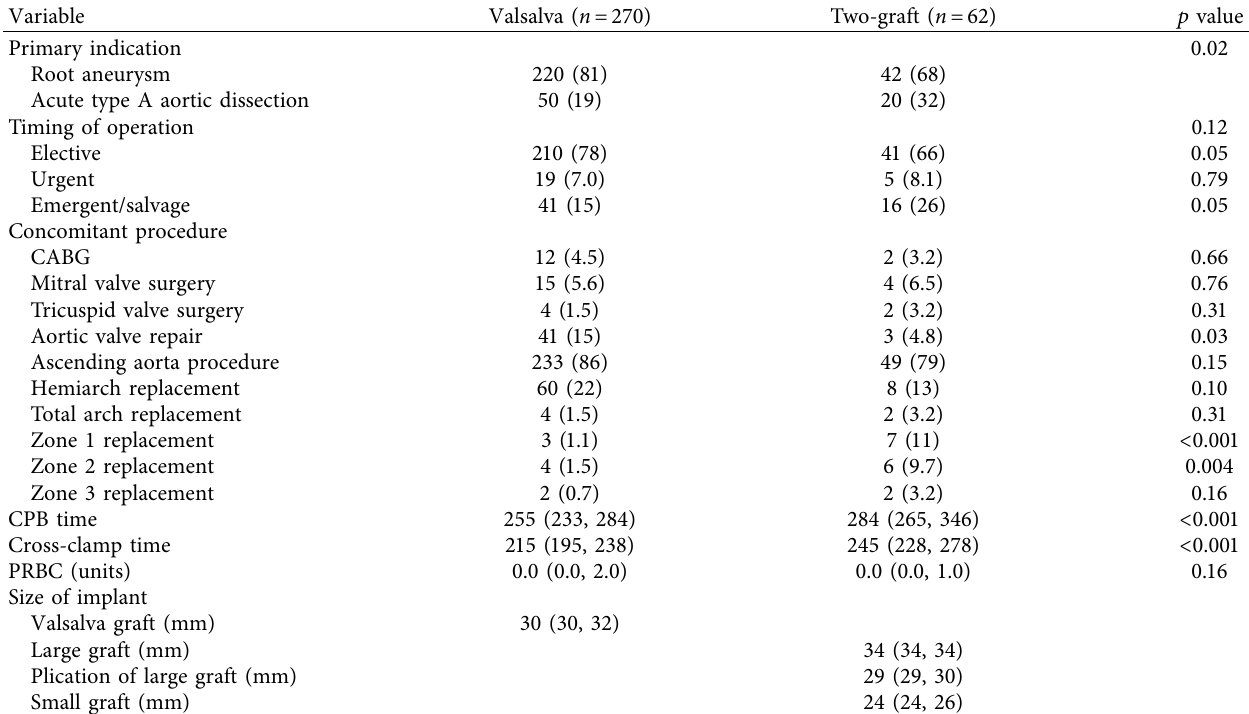
Table 2: Operative data.